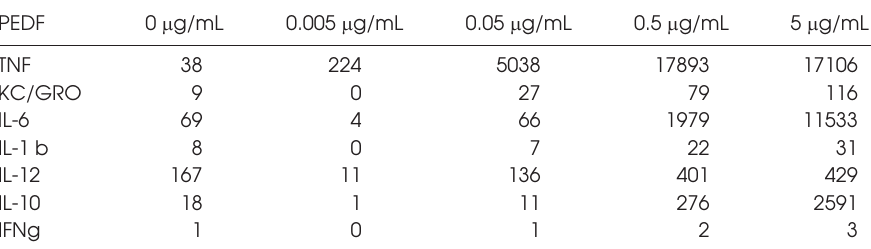
Table 2. PEDF-induced cytokine release at 24 h